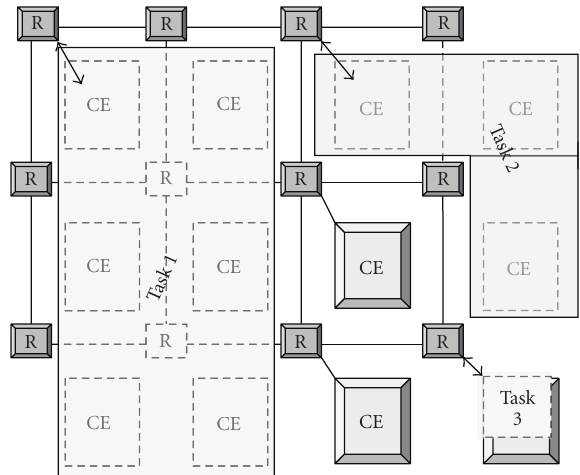
Figure 3: Implementation of three di ff erent tasks (executed by one or several CEs) using a mesh